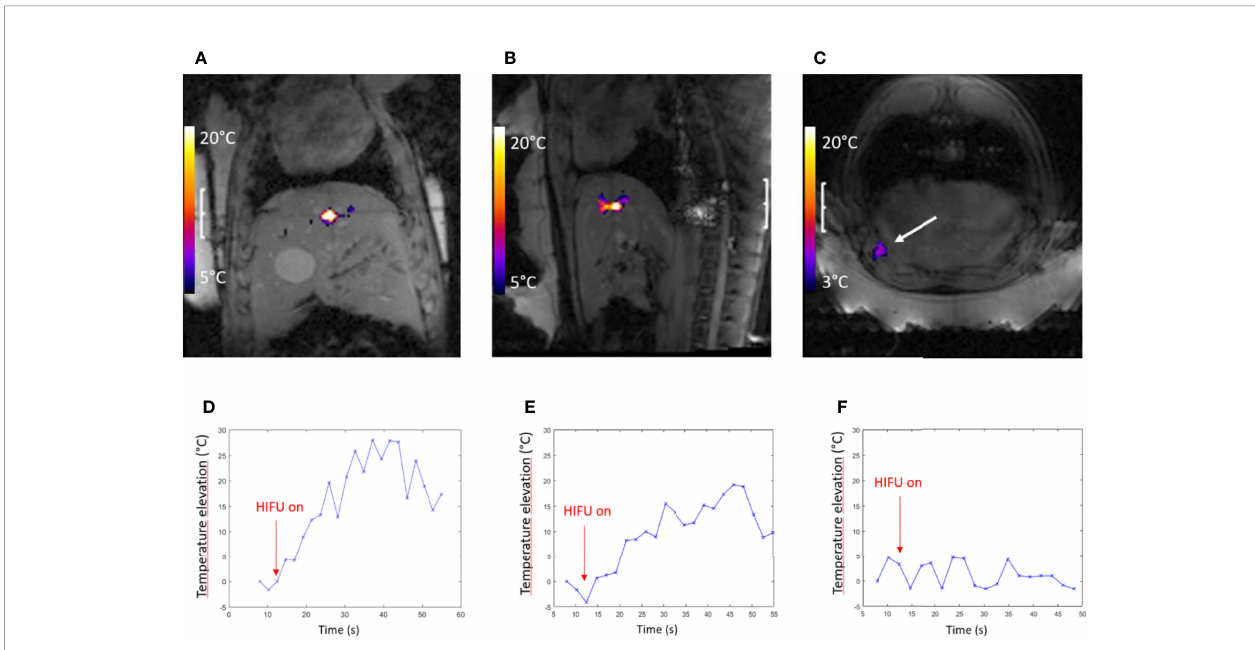
FIGURE 5 | Highlights of pig #1 experiment. PRFS MR temperature map merged with the magnitude image: the FOV is 240 mm 2 , illustrating the temperature elevation at the focal point, coronal (A) and sagittal (B) plane, the end point of sonication ( t = 30 s). (C) Axial plane, monitoring the most exposed rib (see arrow). A color bar of temperature elevation is embedded. (D, E) The highest temperature elevation in coronal and sagittal slice versus time, respectively, spatially averaged in a 2 × 2-pixel ROI. (F) Temperature elevation versus time on the exposed rib shown in frame (C)